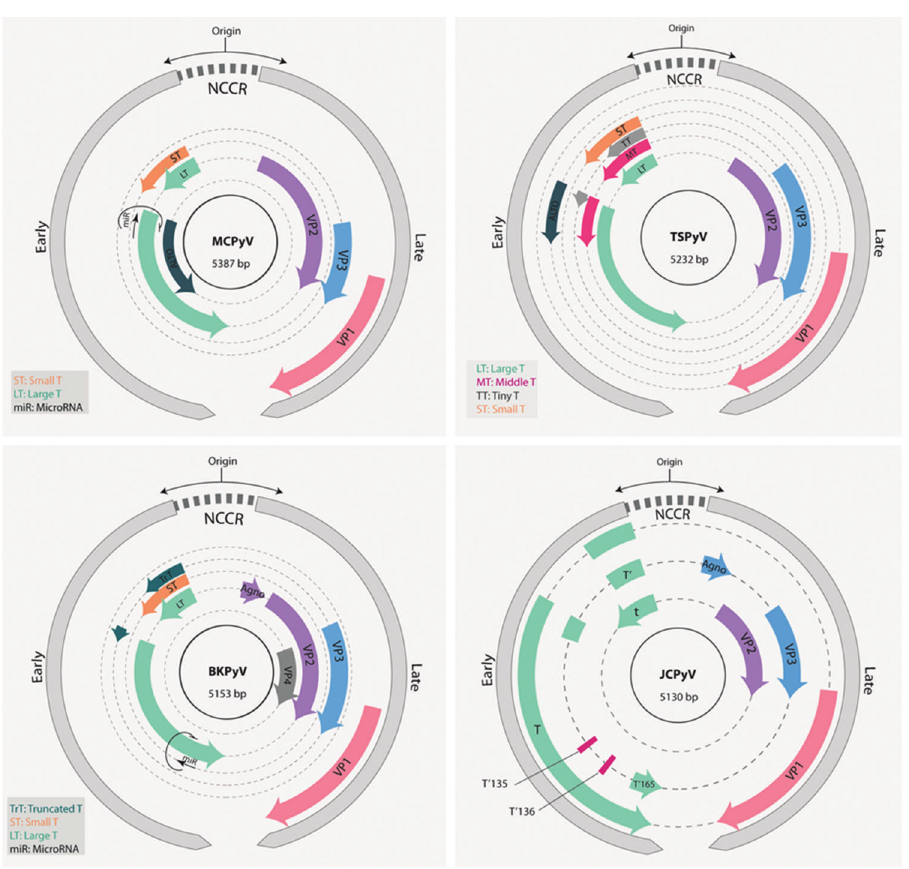
Figure 2 - Schematic representation of the genomes of BKPyV, JCK, MCPyV and TSPvV. The early and late regions (gray) are transcribed from opposite strands of the genome. The early region is transcribed in the counterclockwise direction and harbors the genes coding for the different T antigen isoforms as indicated. The late region expresses the structural genes (VPs) and the agnoprotein ORF (when present). BKPyV, JCV and MCPyV express a microRNA from the opposite strand of the early region. The noncoding control region (NCCR) contains the origin of genome replication and the promoters for the regulation of transcription. For details, see